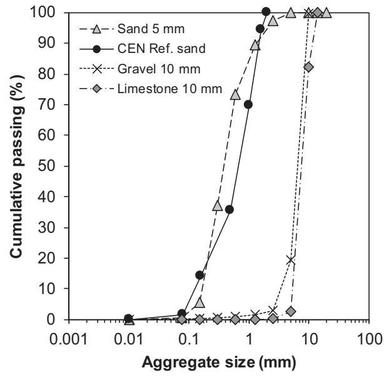
Particle size distribution of aggregates.